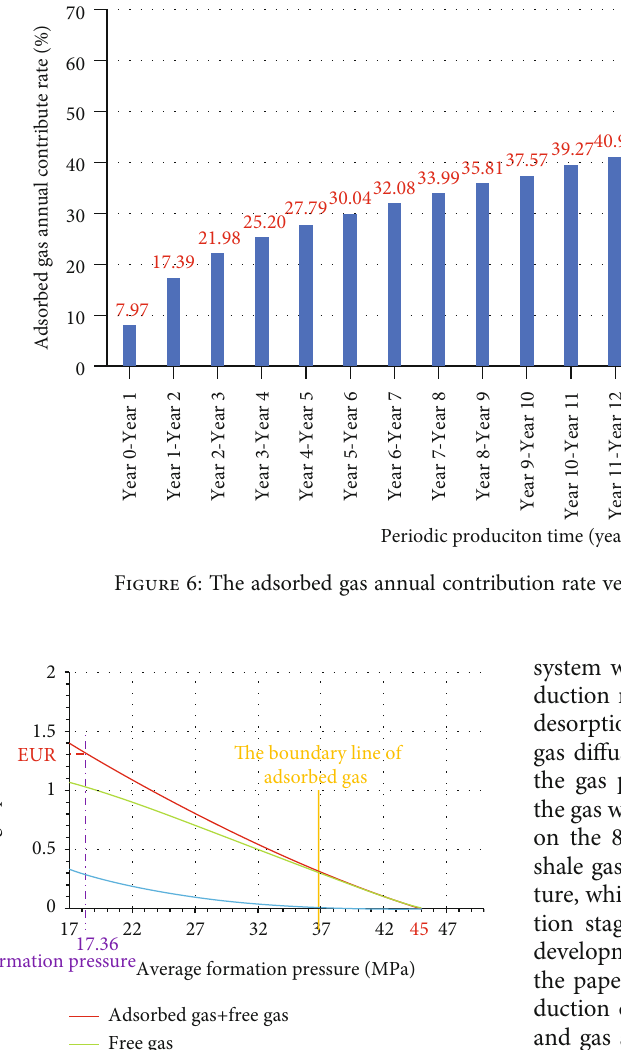
Figure 7: The relationship curve between cumulative gas production and average formation pressure.